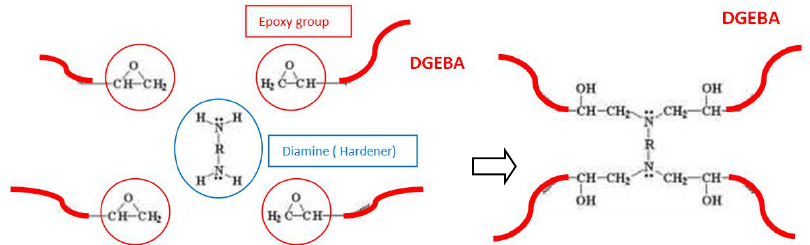
Figure 9. The diamine can initiate four bonds; it can build a polymer network in a short time and can provide a highly crosslinked